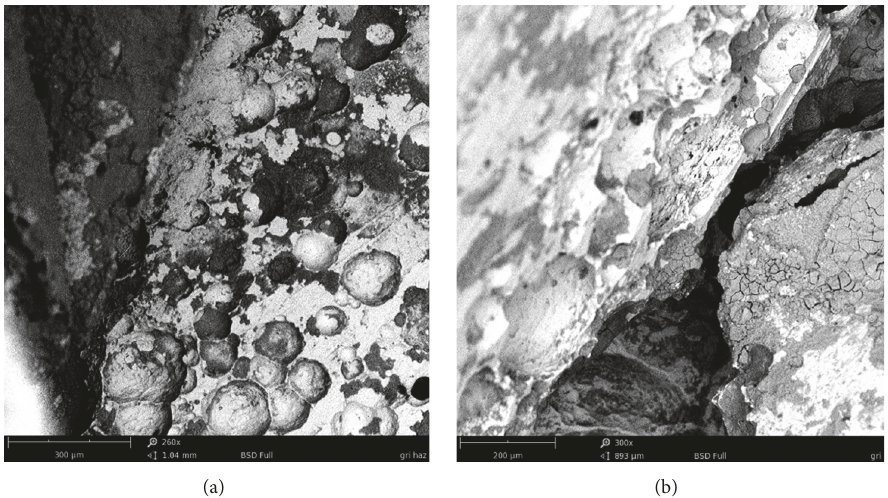
Figure 4: The effect of pitting observed in the HAZ (a) and crack between grille rods (b),